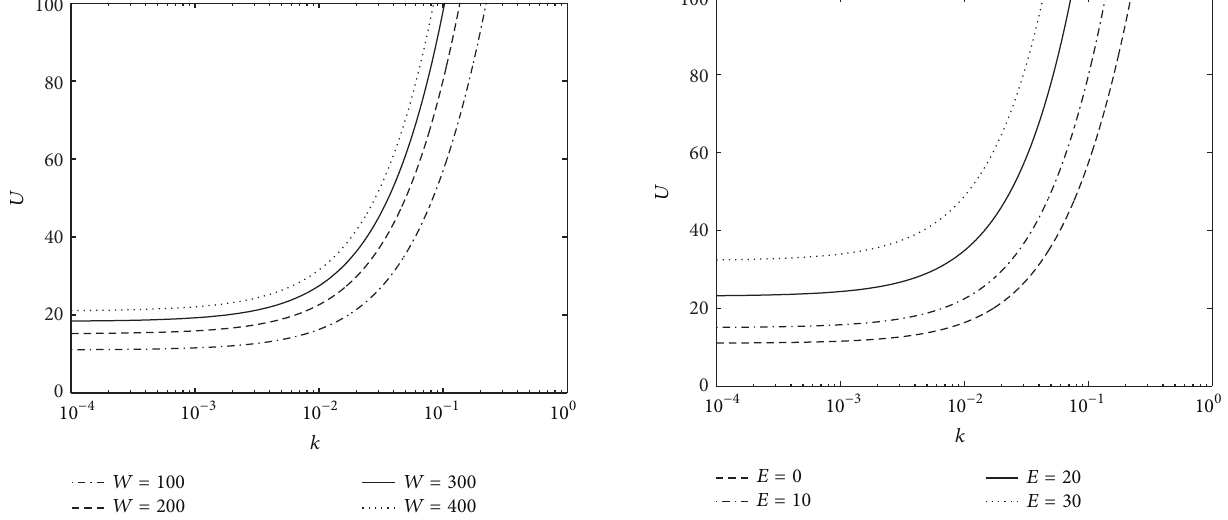
viscosity. Hence, air viscosity has destabilizing effect on the aerodynamic stability analysis of a liquid sheet, while liquid viscosity plays a stabilizing role. As the air viscosity increases, the air flow is impeded and instability occurs.